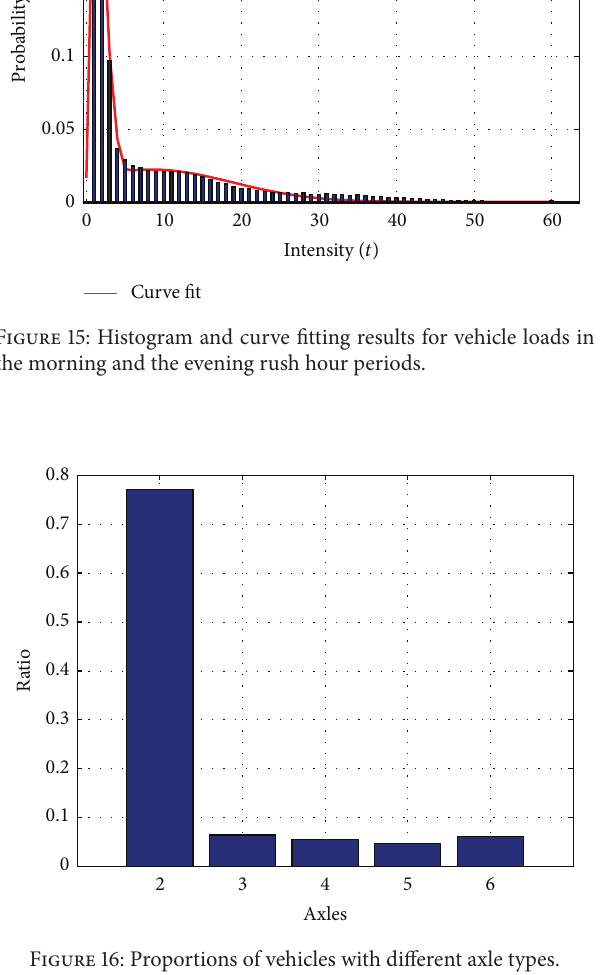
Figure 16: Proportions of vehicles with different axle